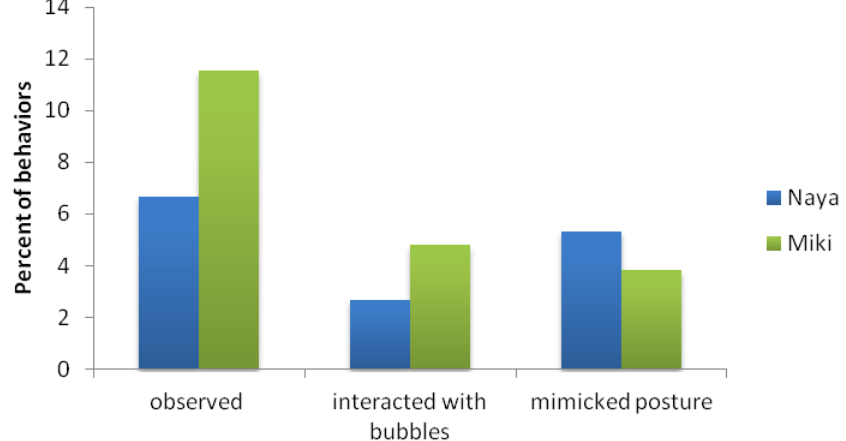
Figure 6. Kimalu observed or imitated the bubble helix behaviors of two other belugas. This graph shows the percentage of each individual’s bubble helix behaviors in which Kimalu either observed or